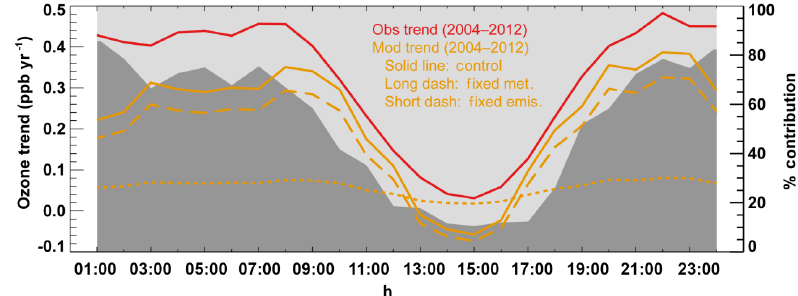
Figure 11. Trends in the modeled surface ozone over the US at different times of day. The yellow lines depict the trends in three model sim- ulations (control, fixed meteorology, and fixed global anthropogenic emissions). The two shaded areas indicate the individual contributions of interannual climate variability (light grey shade) and global anthropogenic emissions (dark grey shade) to the simulated 2004–2012 ozone